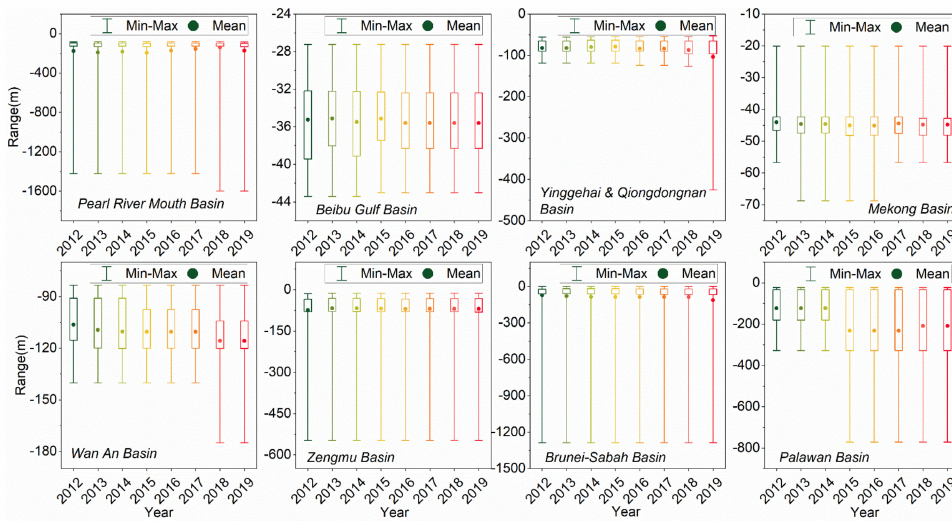
Figure 14. Changes in the water depth of HE targets in each basin from 2012 to